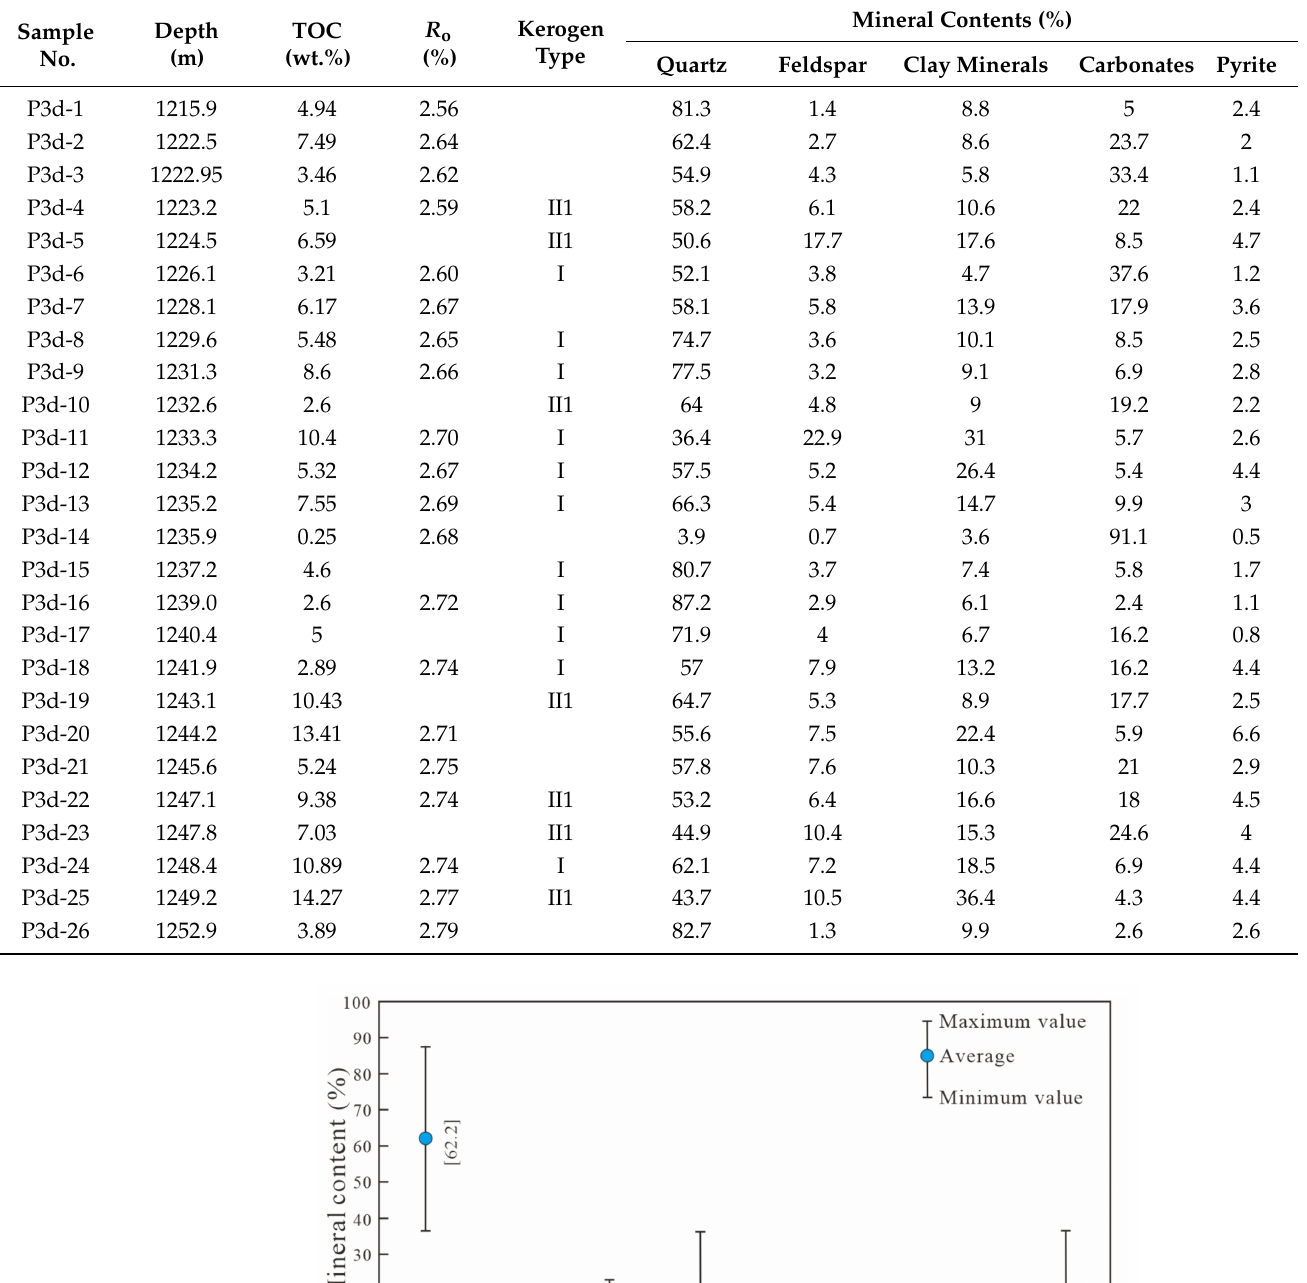
Table 1. Basic characteristics of the Dalong Formation shale samples selected from well ED-2 in Western Hubei.